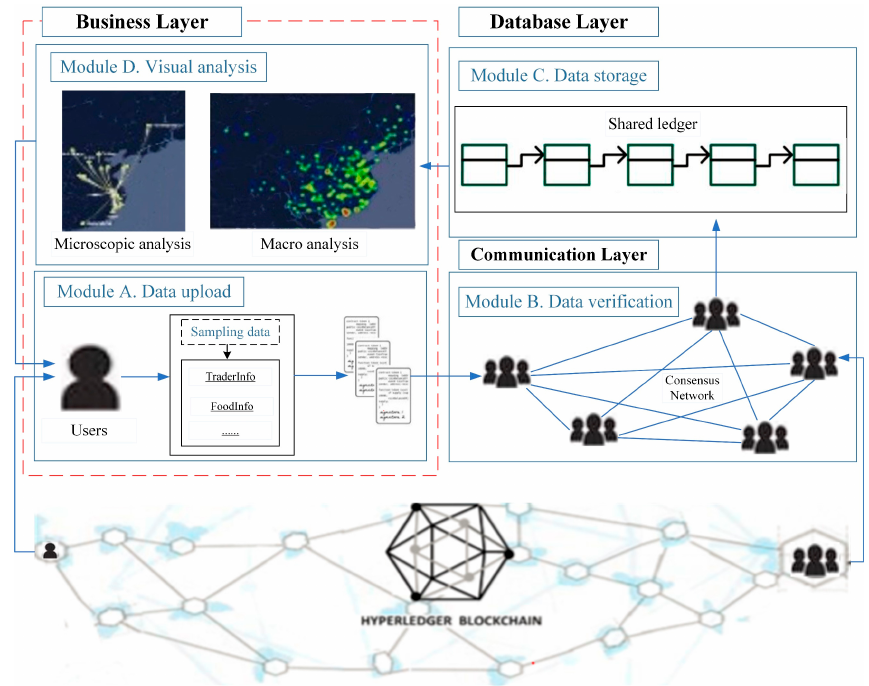
Figure 1. The framework of the method.